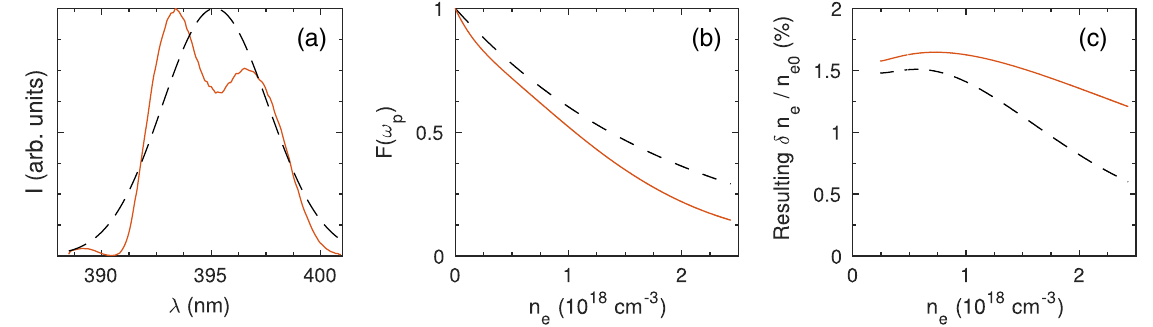
FIG. 2. (a) The measured spectrum of the probe pulse in a recent experiment [21] (solid red line) and a Gaussian fit to it (dashed black line). (b) Comparison of the spectral overlap factors F ð ω TESS peak as a function of gas cell pressure, assuming that the hydrogen gas was fully ionized by the driving laser. (c) Deduced wakefield amplitude as a function of cell pressure assuming spectral overlap factors F ð ω showing the mismeasurement of an example wakefield amplitude when assuming a Gaussian